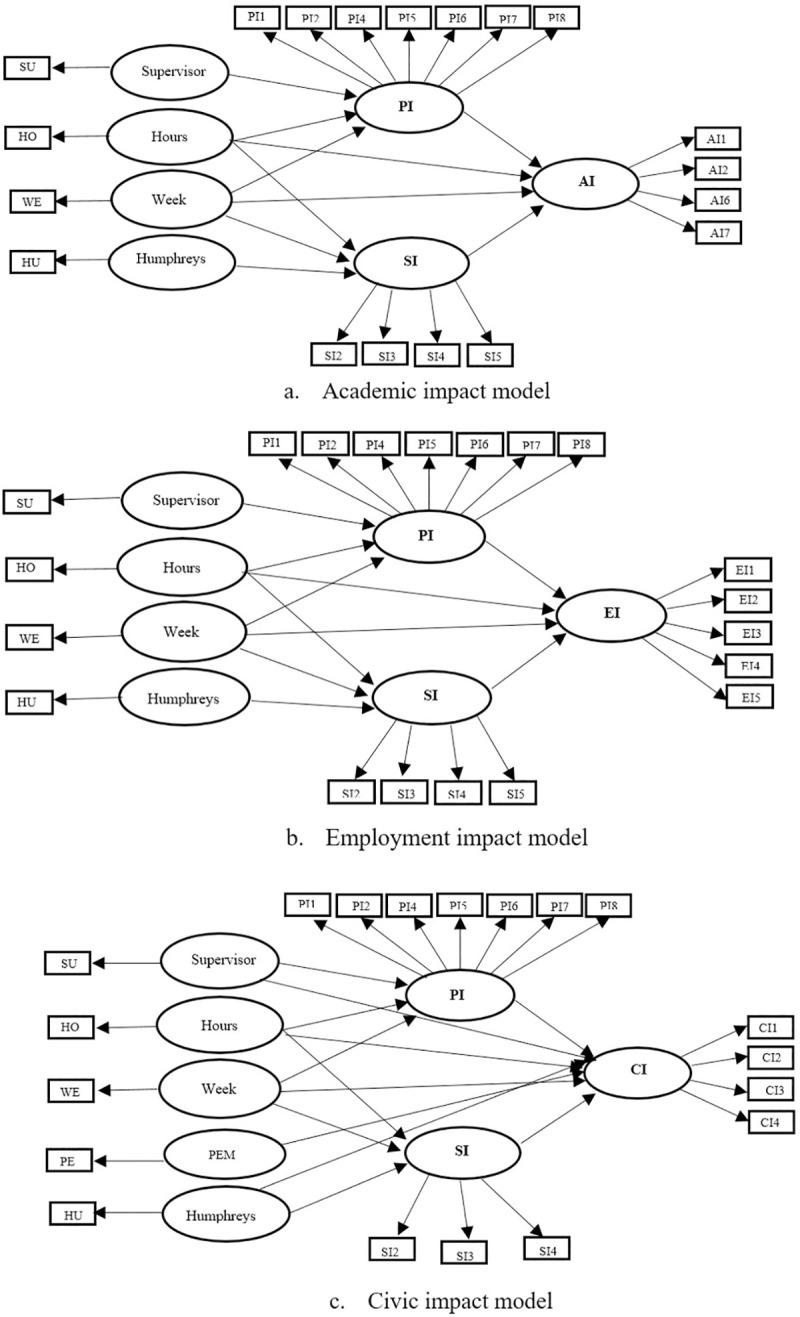
Research models.